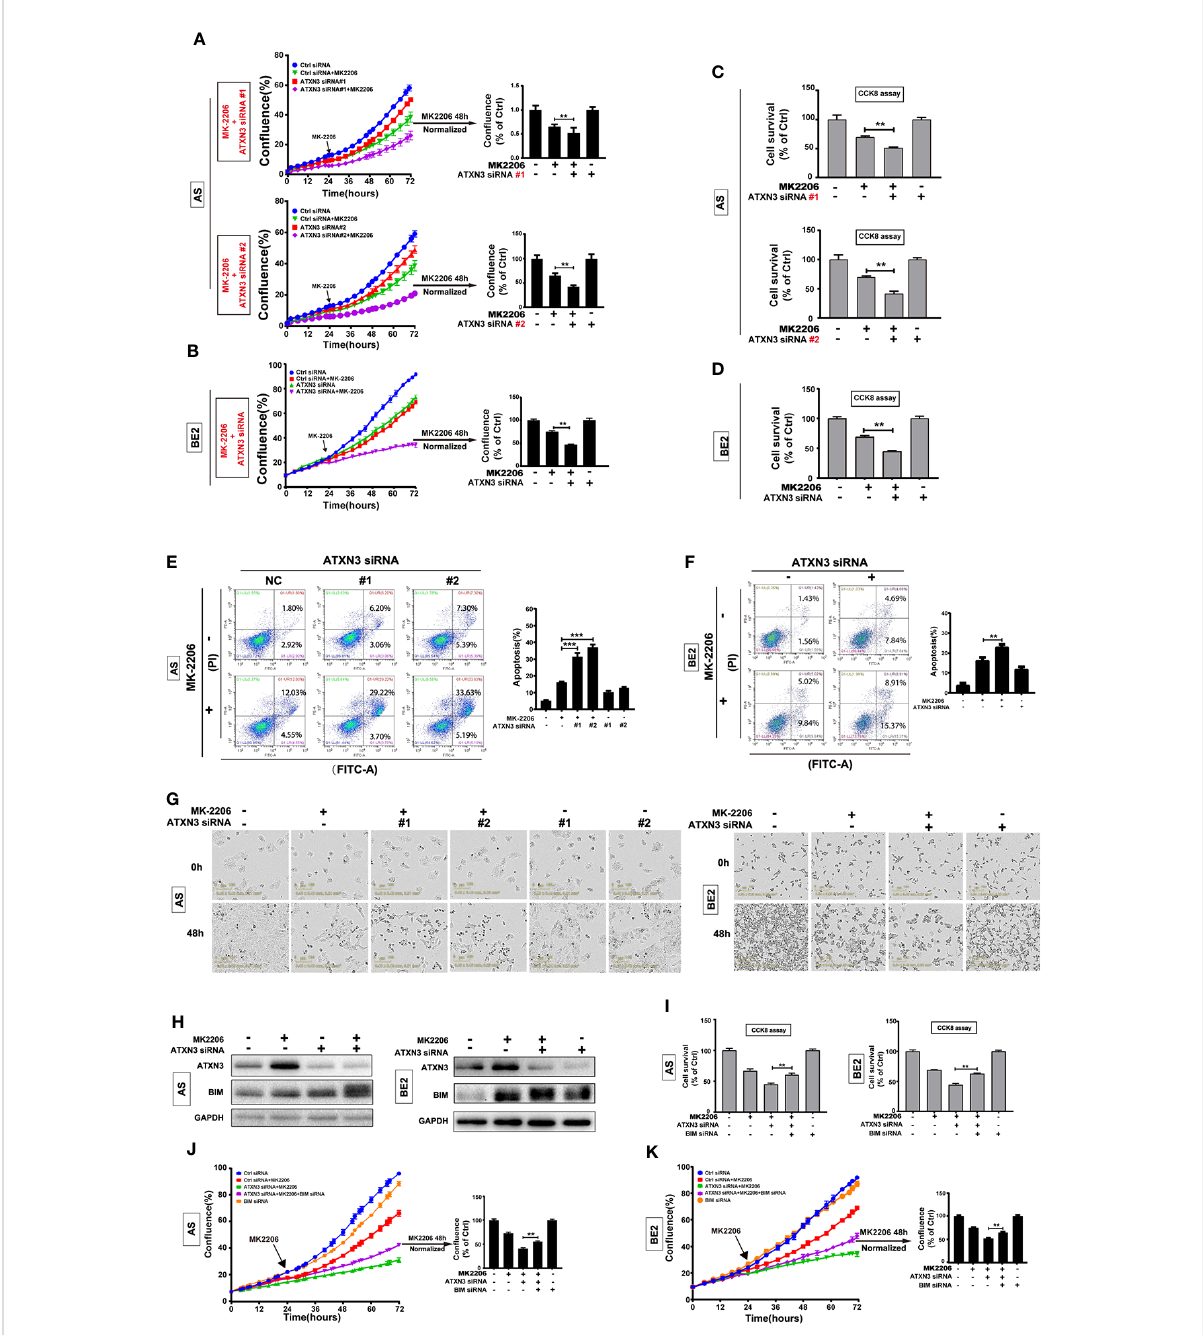
FIGURE 3 BIM mediated the cell death induced by a combination of MK-2206 treatment and ATXN3 downregulation in NB cells. AS cells were transfected with ATXN3 siRNAs (#1 and #2) and BE2 cells were transfected with ATXN3 siRNA #2 (marked as ATXN3 siRNA) for 16 h followed by 48 h treatment of MK-2206. (A, B) Cell con fl uence was dynamically detected by IncuCyte Zoom and analyzed at the end of experiment; (C, D) Cell survival was detected by CCK8 assay; (E, F) Cell apoptosis was detected by Annexin V/PI fl ow cytometry. Bar, SD, **, P< 0.01, ***, P<0.001, ATXN3 siRNAs + perifosine vs. control siRNA + perifosine; (G) The images of AS and BE2 cells with ATXN3 siRNAs transfection and perifosine treatment at 0 and 48 h were recorded; (H) AS and BE2 cells were transfected with ATXN3 siRNA2 (marked as ATXN3 siRNA) for 16 h, and treated with MK-2206 for 24 h, the expression of ATXN3 and BIM was detected by Western blot; (I) BIM siRNA #1 (marked as BIM siRNA) and ATXN3 siRNA #2 (marked as ATXN3 siRNA) were transfected into AS and BE2 cells alone or combination, then the cells were treated with MK- 2206 for 48 h, cell survival was detected by CCK8 assay; (J, K) Cell con fl uence was detected by IncuCyte Zoom. Bar, SD, **, P<0.01, ATXN3 siRNA + MK-2206 + BIM siRNA vs. ATXN3 siRNA +